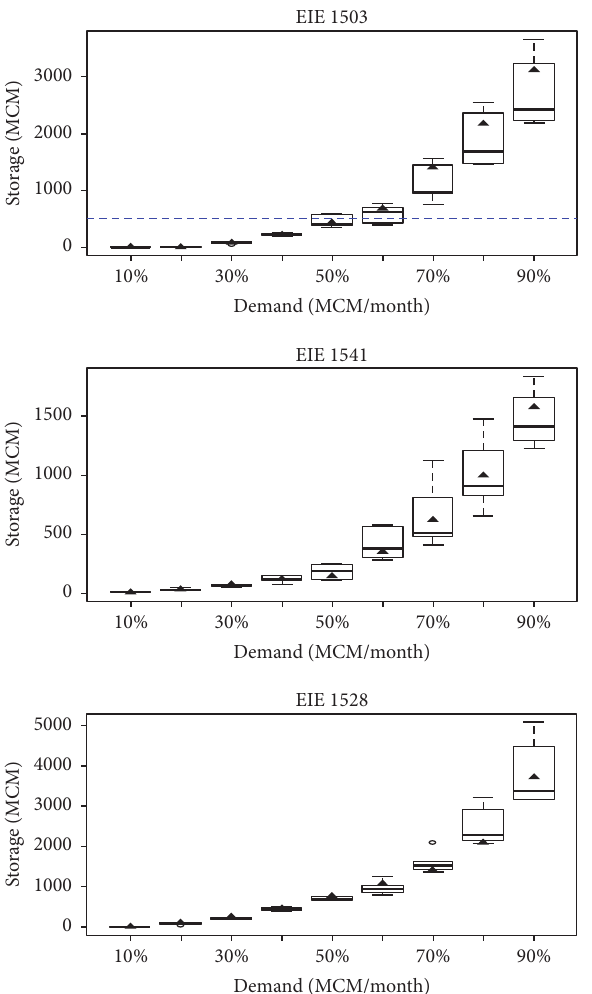
Figure 8: Sequent peak results based on the demand of 10–90% of mean discharge from the temporal approach. The triangle denotes the observed